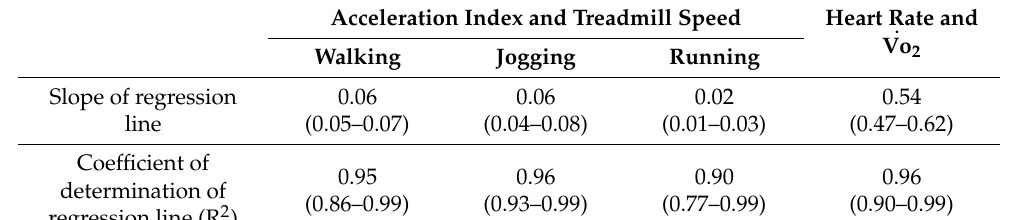
Figure 3. Mean and standard deviation of ( a ) heart rate (bpm), ( b ) oxygen uptake ( Vo(cid:4662) (cid:2870) ), and ( c ) acceleration index at each treadmill speed across all participants.